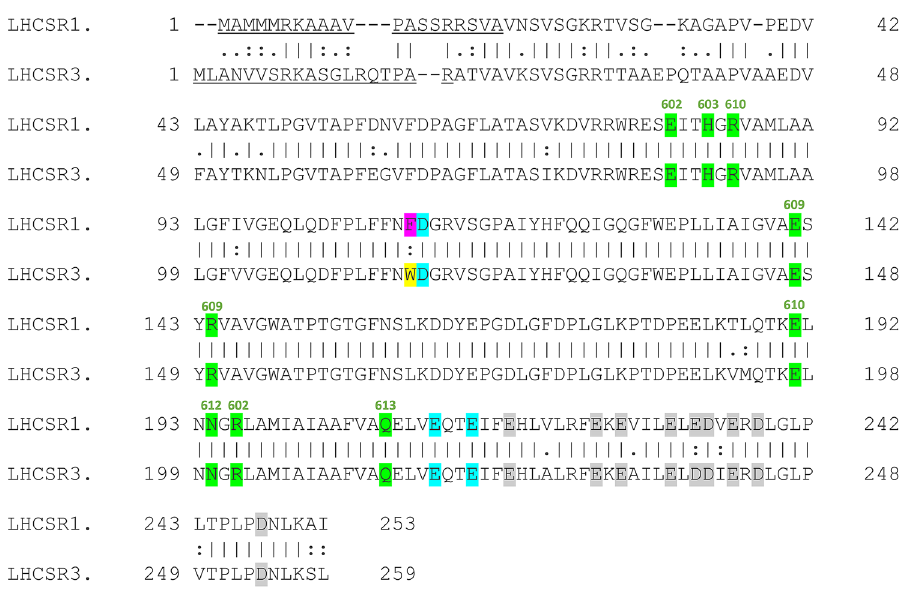
Figure 1. Protein sequence alignment of LHCSR1 and LHCSR3. LHCSR1 and LHCSR3 protein sequences from C. reinhardtii were alignment by using Pairwise Sequence Alignment tool. Chloroplast transit peptide predicted by TargetP is underlined. Chlorophyll binding residues are highlighted in green and the coordinated chlorophyll is reported in green for each amino acid. Protonatable residues involved in LHCSR3 protein activation reported in 27 and in 26 are respectively highlighted in cyan and grey. Not conserved phenylalanine (F116) residue is highlighted in